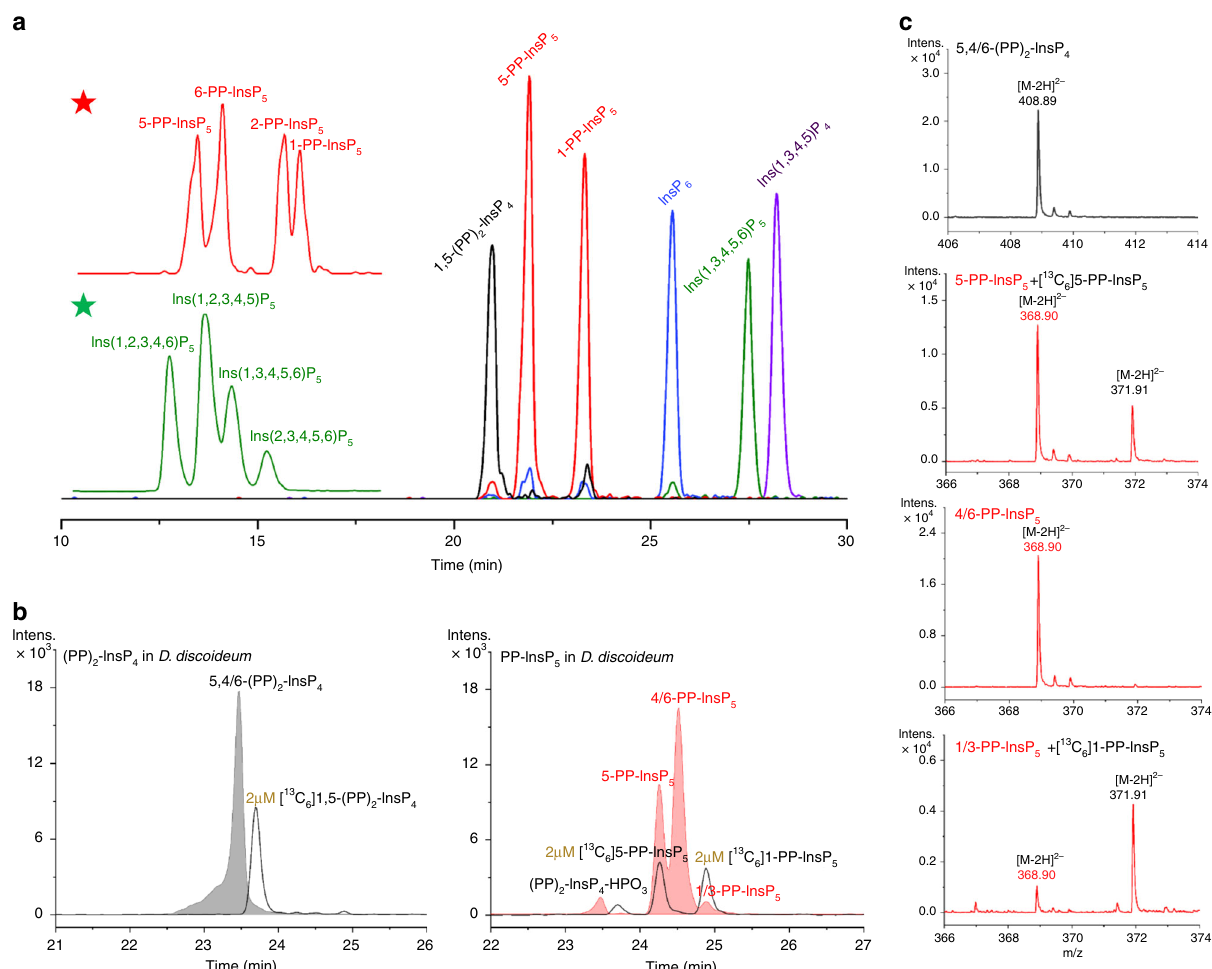
Fig. 4 CE-ESI-MS analysis of Dictyostelium discoideum extract. a Separation of PP-InsP and InsP standards using a modi fi ed BGE (30 mM ammonium acetate titrated with NH 4 OH to pH 9.0). Enlarged inserts for PP-InsP 5 (red star) and InsP 5 (green star) reveal the separation of all regioisomers using the following parameters: CE voltage: 30 kV, CE current: 19 µ A, injection: 50 mbar, 10 s (10 nL), solutes: 10 µ M for Ins(1,3,4,5,6)P 5 , InsP 6 , 5-PP-InsP 5 , 1-PP- InsP 5 , and 1,5-(PP) 2 -InsP 4 ; 20 µ g/mL for Ins(1,3,4,5)P 4 . b PP-InsPs in D. discoideum extracts. PP-InsP regioisomers could be ef fi ciently assigned and quanti fi ed in single runs with spiked (isotopic) standards: major 5,4/6-(PP) 2 -InsP 4 , 4/6-PP-InsP 5 , and 5-PP-InsP 5 , minor 1/3-PP-InsP 5 . c Mass spectra for PP-InsPs in D. discoideum in b. Three independent D. discoideum AX2 (wild type) extracts were analyzed giving identical results. Source data are provided as a Source Data fi